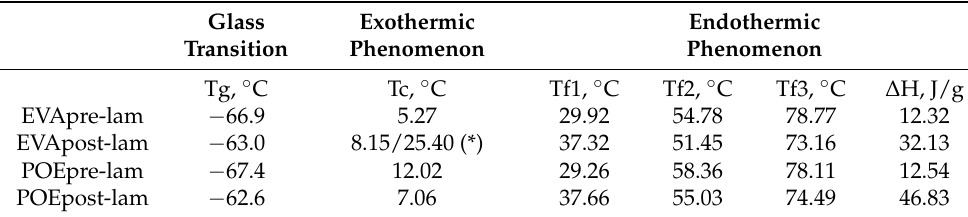
Figure 2. DSC thermograms of ( a ) EVApre-lam and EVApost-lam and ( b ) POEpre-lam and POEpost-lam commercial samples. Table 1. Glass transition (Tg), exothermic and endothermic peaks (Tc and Tf) and fusion enthalpy ( Δ H) of pre- and post-laminated EVA and POE samples.